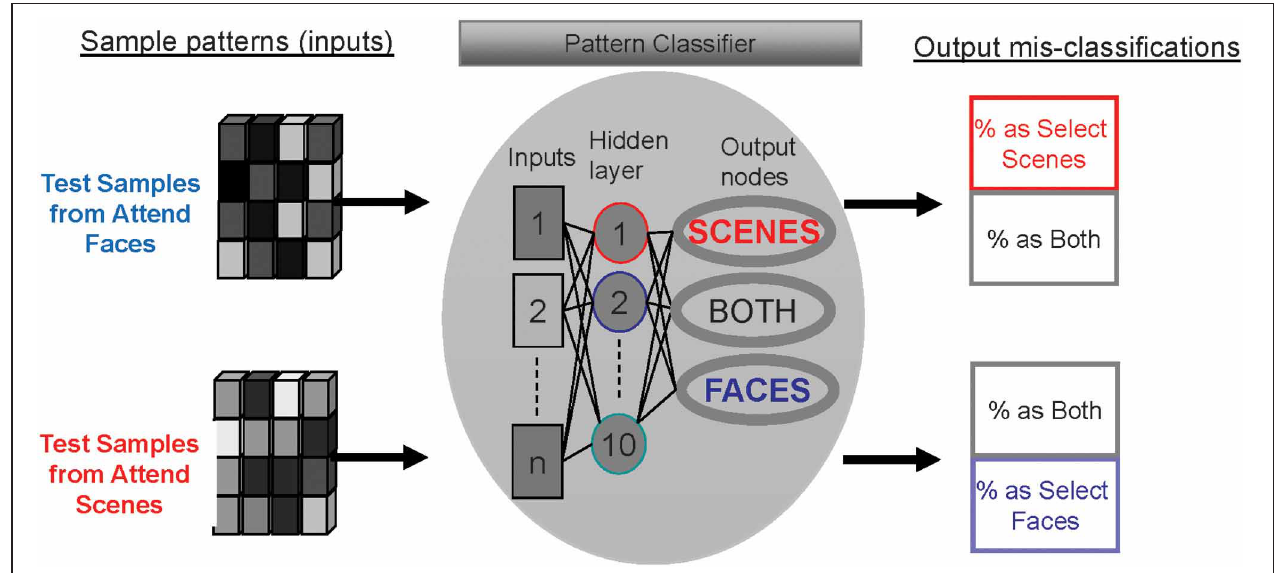
FIGURE 3 | Method for determining the distinctiveness of activity patterns for each attention condition using mis-classification rates of a multi-layer perceptron.